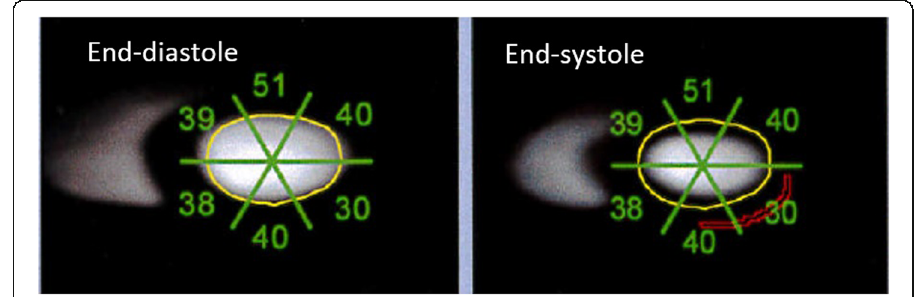
Fig. 7 Automated segmentation of “ pseudo-planar ” PET/CT images summed along the cardiac short